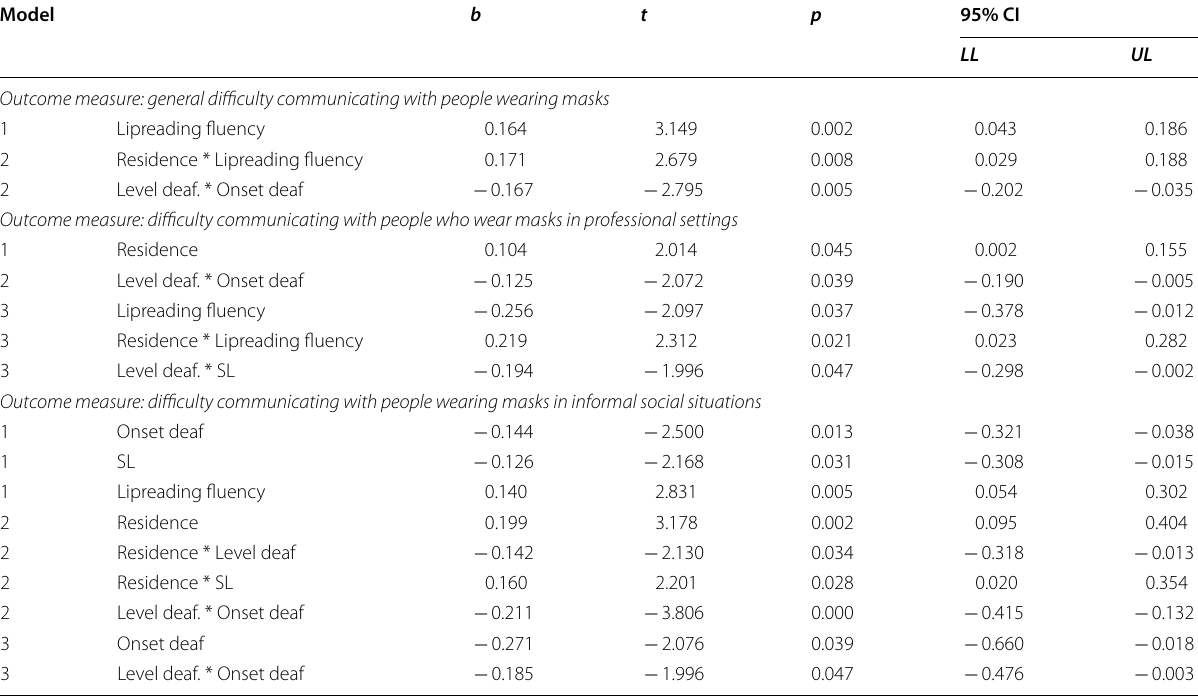
Table 4 Summary of significant effects in the regression analysis for experienced difficulty communicating with people who wear